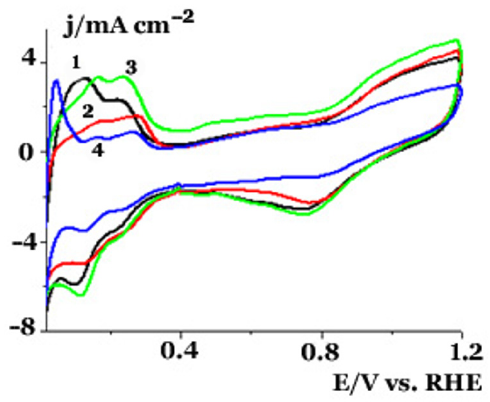
Figure 3. Cyclic voltammograms recorded at the commercial Pt/C (1), PtFe/C (2), PtMo/C (3), and PtMoSn/C (4) catalysts at a scan rate of 0.05 V s − 1 in argon purged 0.5 M H 2 SO 4 at room temperature.